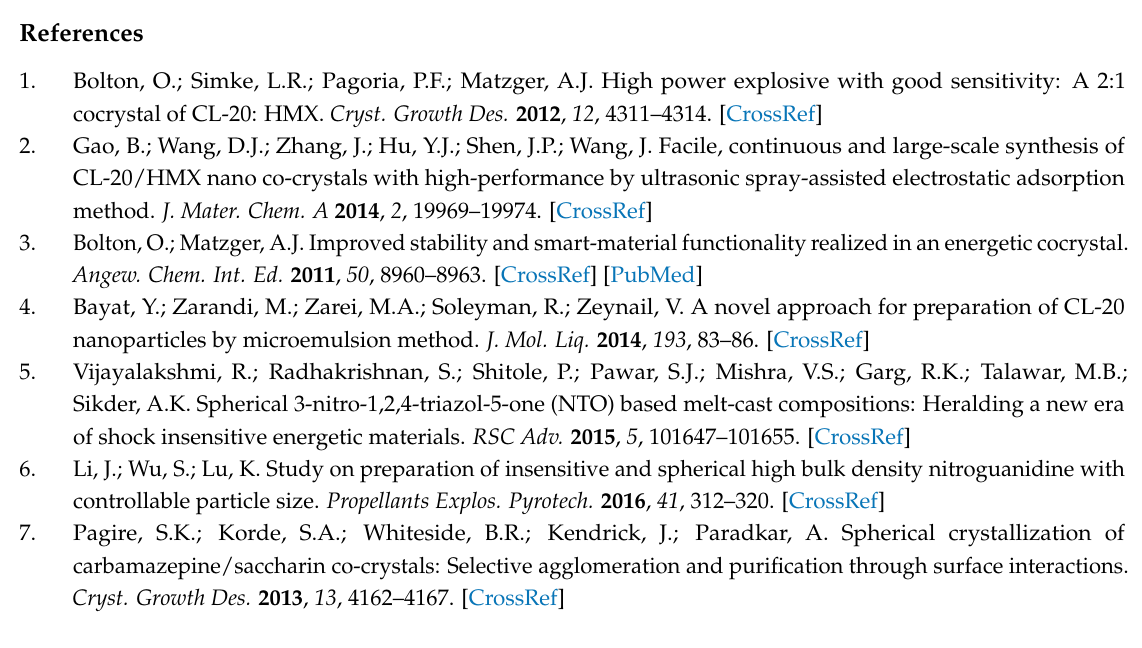
s1, Figure S1: Particle size distribution of as-formed CL-20/PNCB composite, Table S1: Make comparable with every explosive properties (Eg:Sensitivity, VOD and DP, etc.) with already known composites with CL-20. Author Contributions: C.G. and G.Y. conceived and designed the experiments; Y.Z., Y.L., B.G., and D.W. performed the experiments; Y.Z. analyzed the data and wrote the paper; C.G. and G.Y. checked the